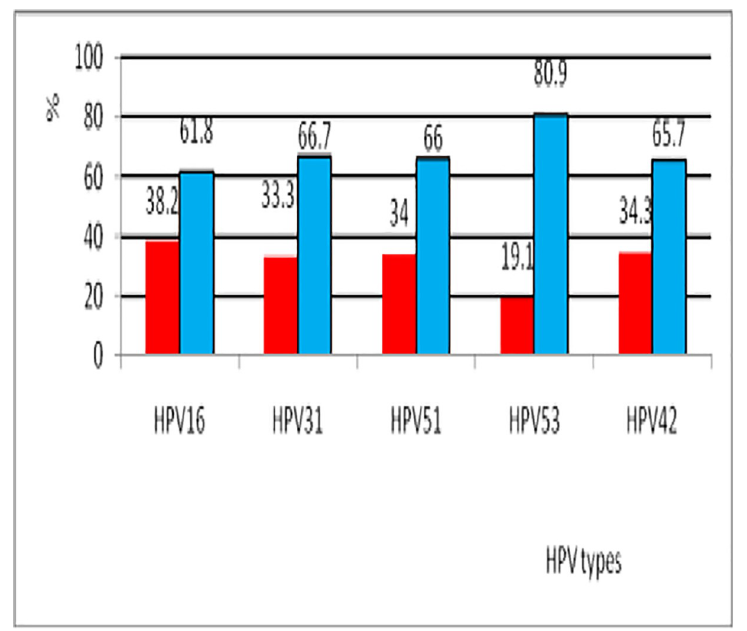
Fig 2. HPV genotypes in cases of single infection and multiple